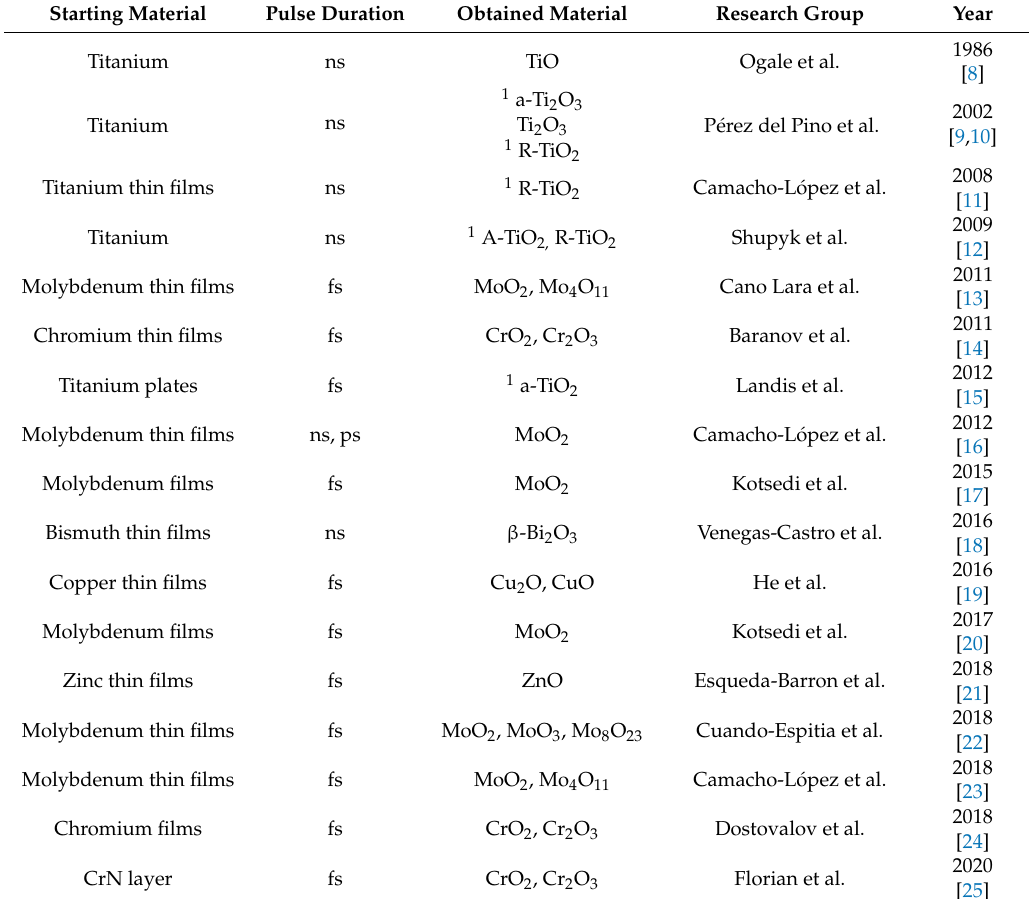
Table 1. Pulsed laser-induced oxidation of metals published in the